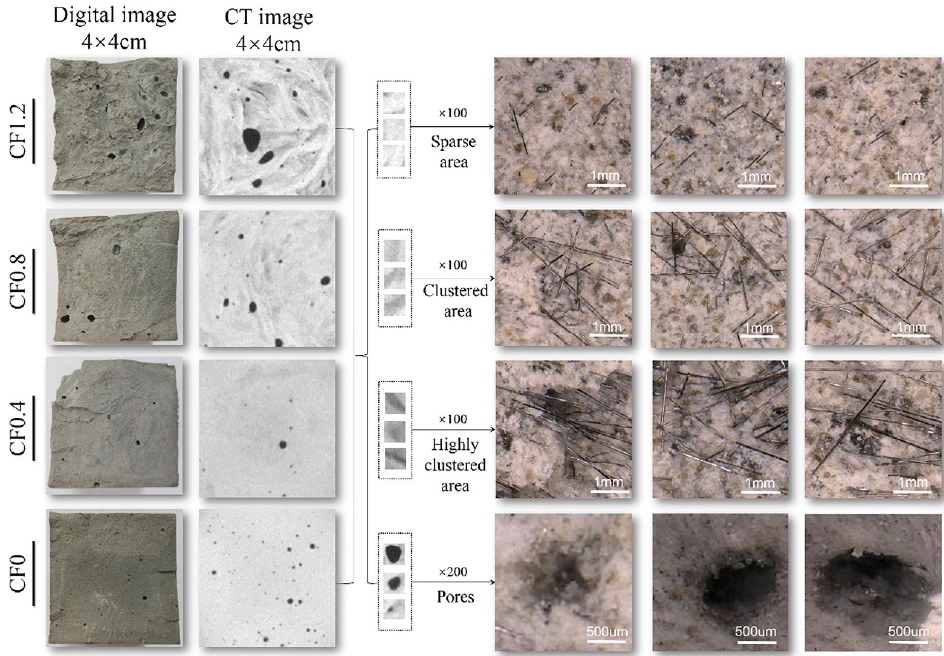
Figure 6. The actual fracture appearance, CT images, and micrograph of CFRC